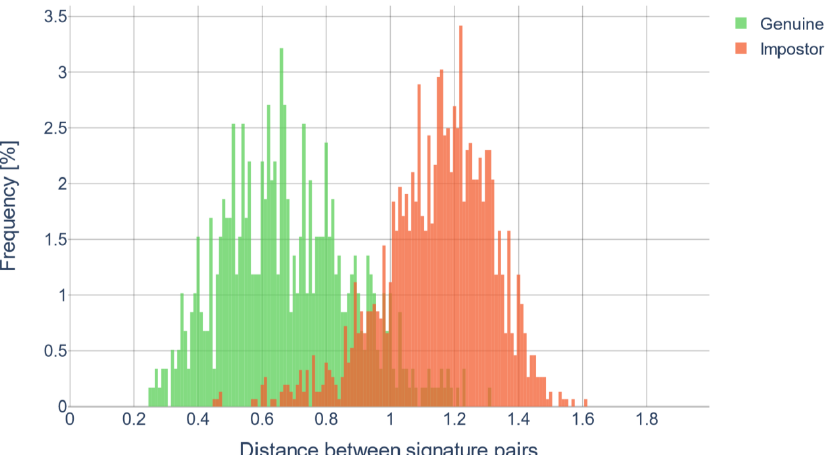
Figure 15. “ Genuine ” histogram shows the distribution of distances for pairs of signatures belonging to a single person. Simultaneously, “ Impostor ” depicts the distance distribution for pairs consisting of one genuine and one forged signature. A boxplot showing the separation between “ Genuine ” and “ Impostor ” scenarios is additionally shown in Figure 16.